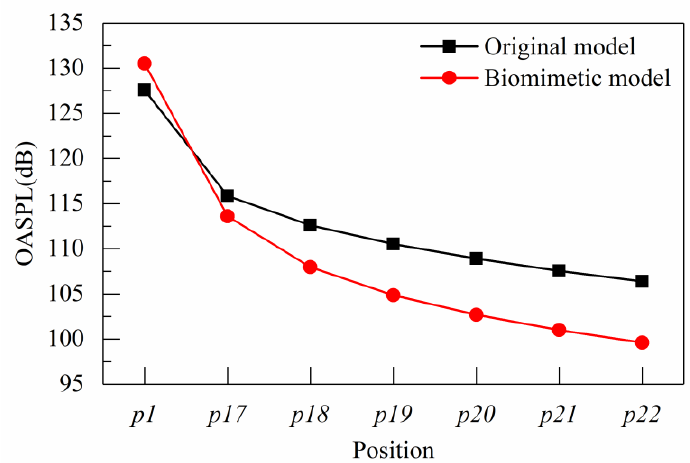
Figure 18. Comparison of the predicted OASPLs of the original hydrofoil and biomimetic hydrofoil at the six observing points in the radial direction of the near sound field.